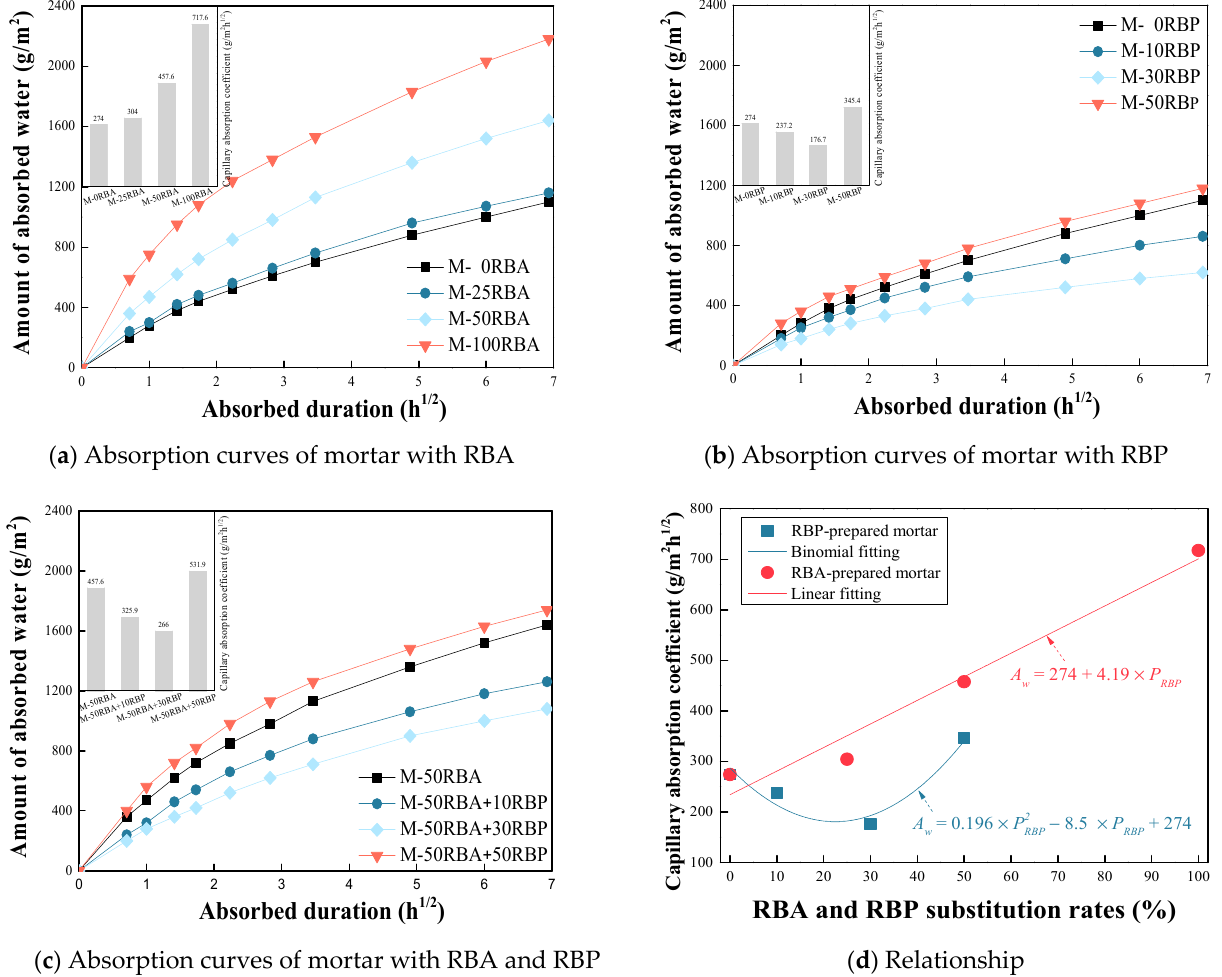
Figure 12. Water absorption of cement mortar with RBA and RBP.